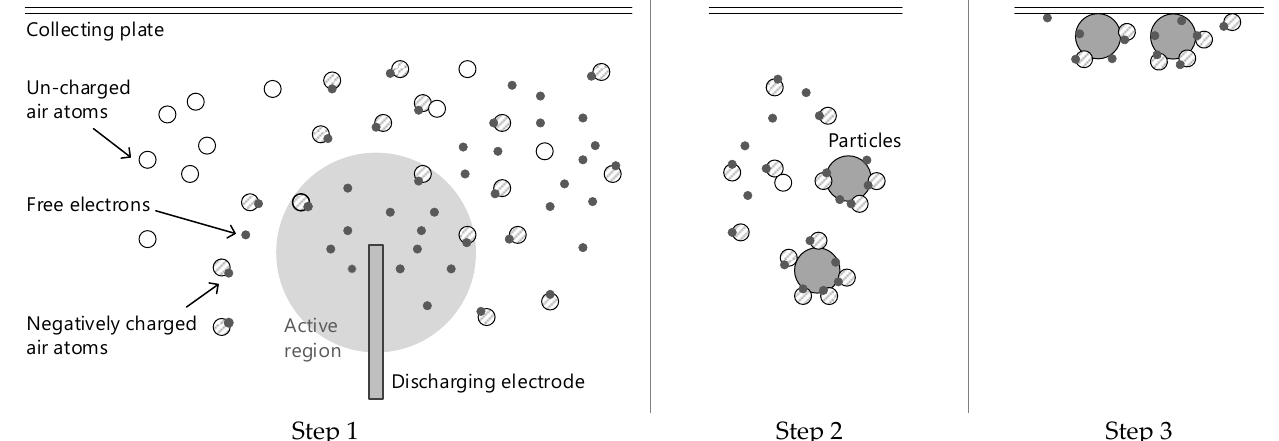
Figure 6. The ESS operation in collecting the particles from the air.